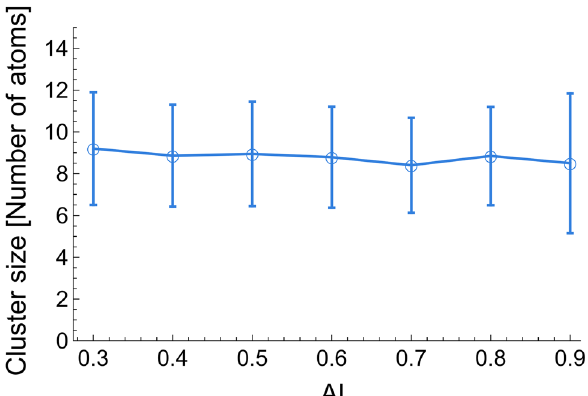
Figure 5. Cluster size in Al–Ni alloys with different Al content obtained from MD simulations.